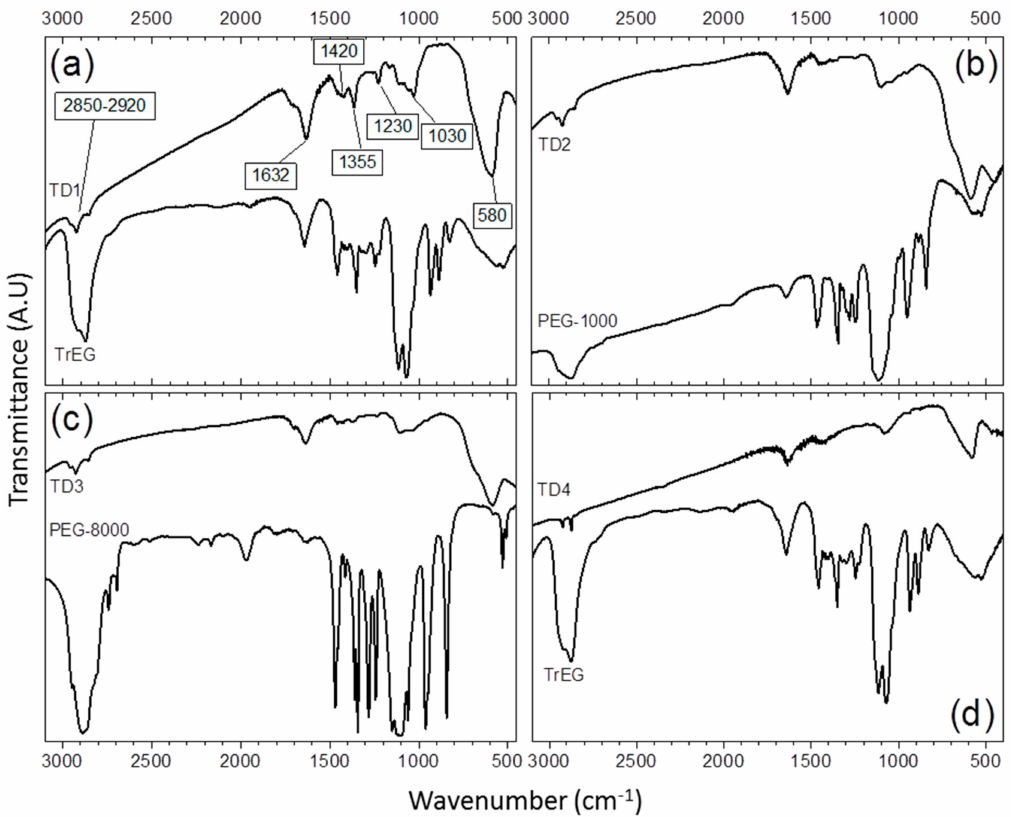
Figure 5. The transmittance IR spectrum of thermal decomposition samples. ( a ) Sample TD1. The peaks that are assigned to specific stretching or bending vibrations of the bonds of TrEG molecule are noted. ( b ) IR spectrum of TD2, ( c ) TD3, and ( d )